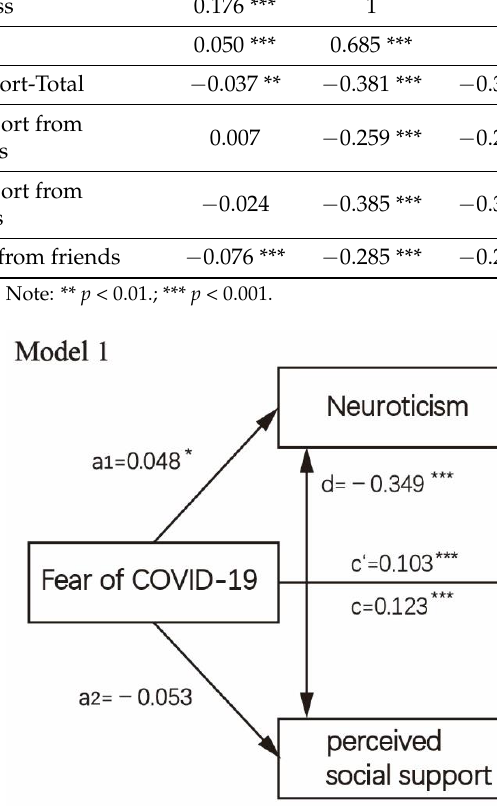
Figure 5 (Model 4), the direct effect of fear of COVID- 19 on perceived stress (c’) was 0.100